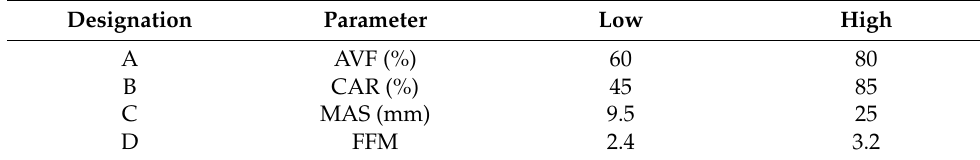
Table 2. Limits of the tested